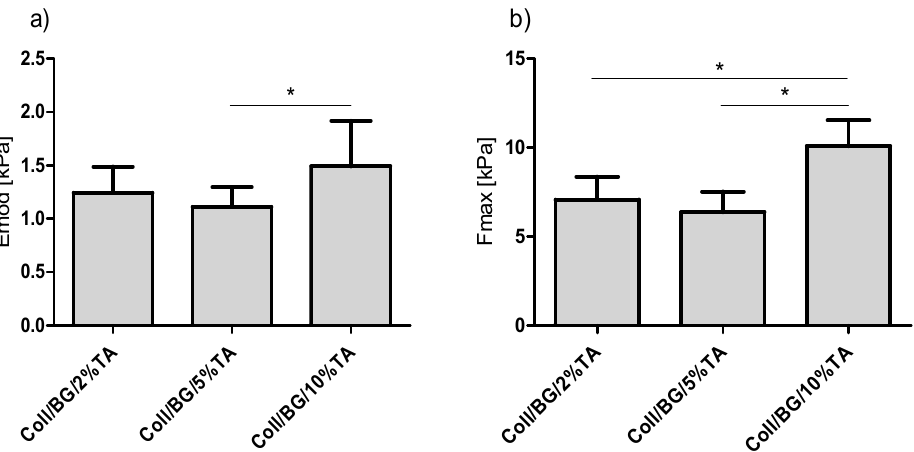
Figure 3. The mechanical parameters of hydrogels with different tannic acid concentrations: ( a ) comprehensive modulus; ( b ) maximum tension; * p < 0.05 between groups.